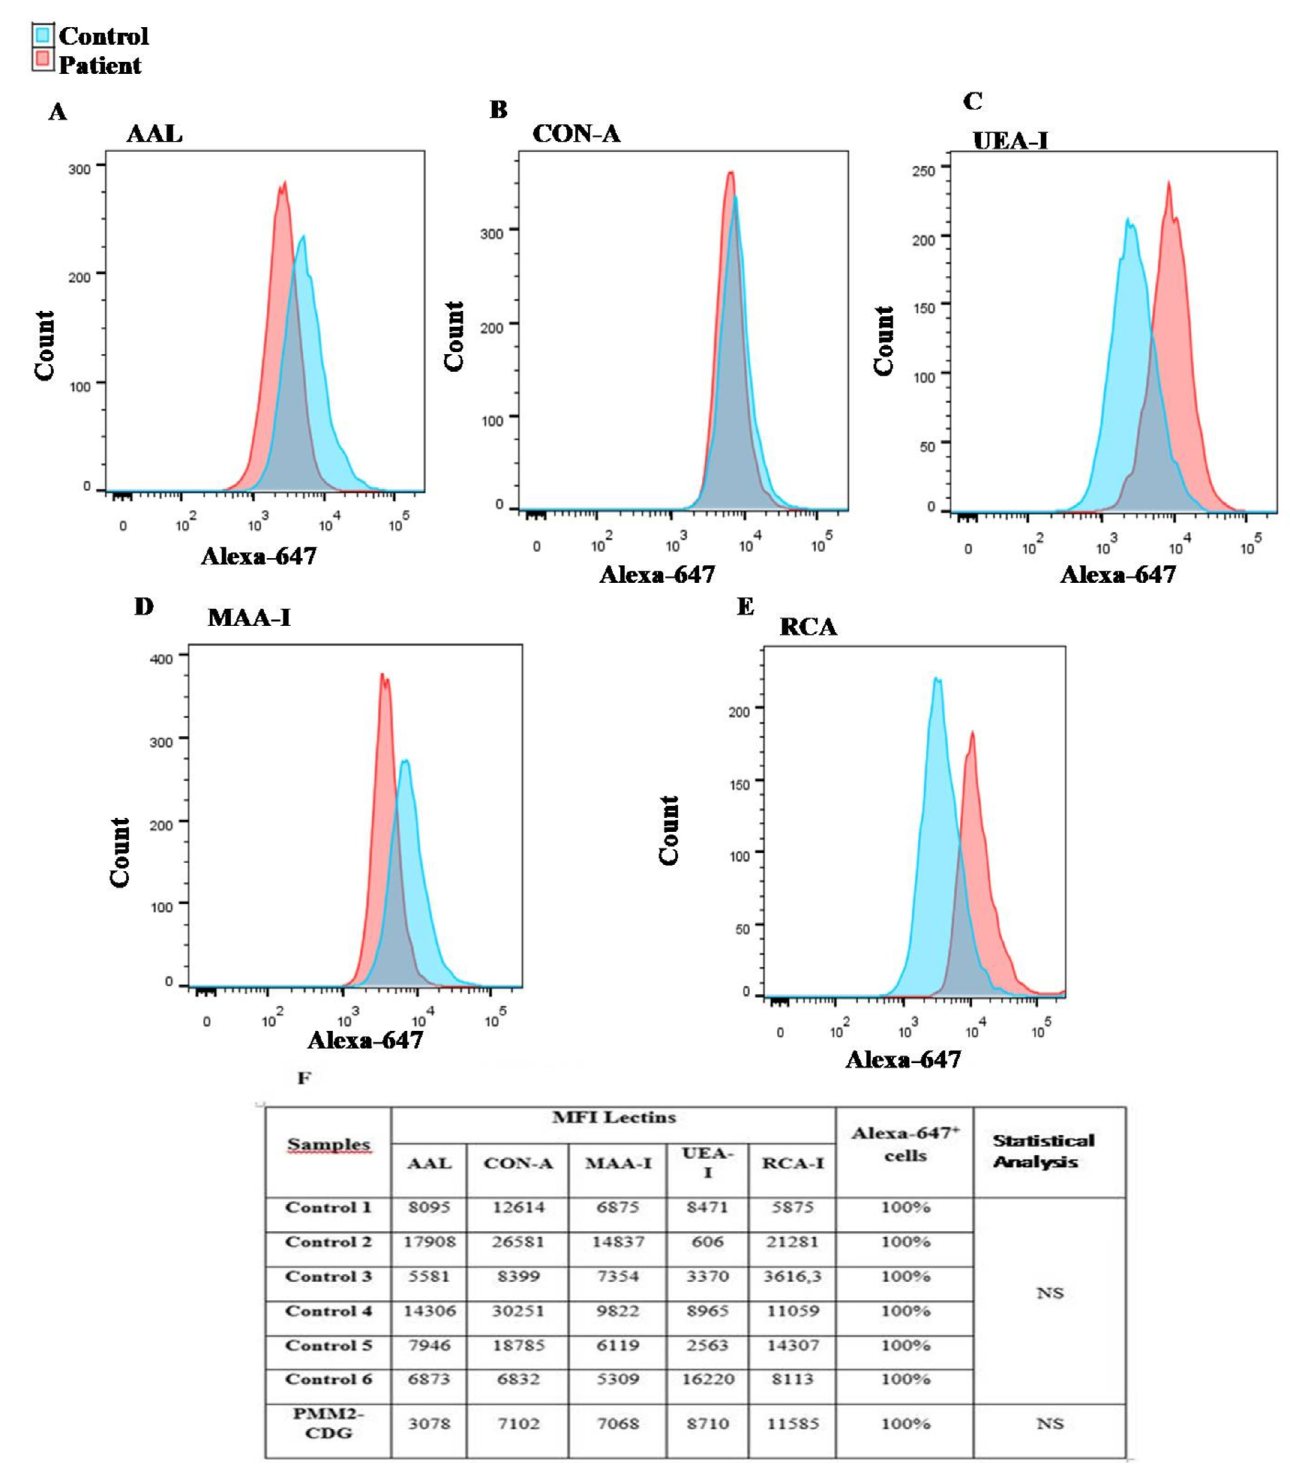
Figure 3. Flow cytometric analysis of platelet surface membrane glycosylation. Platelet populations were gated based on positive CD41-PE staining and lectins detected by Alexa Fluor 647-conjugated streptavidin. No significant (NS) binding differences were detected between control and PMM2-CDG patient samples for the following 5 lectins: A. AAL (specific for α1,6- linked fucose). B . CON-A (specific for α-mannose). C. UEA-I (specific for α-fucose). D. MAA-I (specific for sialic acid bound to galactose α-2,3). E . RCA-I (specific for β-galactose). Histograms superpose the control (blue peaks) and patient (read peaks) for comparison. F. Summary results. MFI and CD41 + /Lectin + platelet counts (%) for each lectin are indicated for control and PMM2-CDG patient